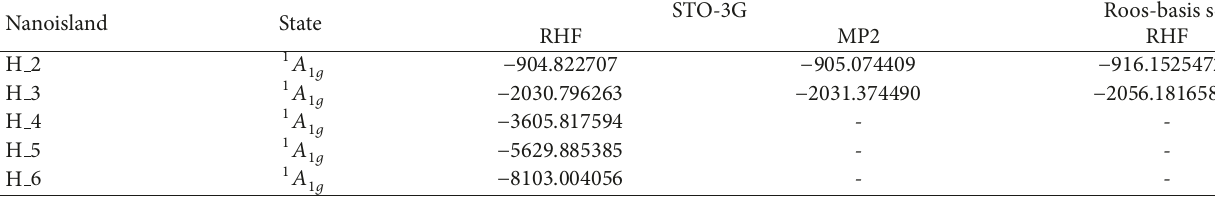
Table 4: Energies for the different hexagonal nanoislands in hartree.